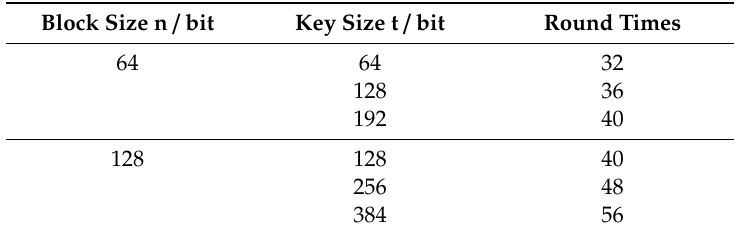
Table 2. Number of rounds for